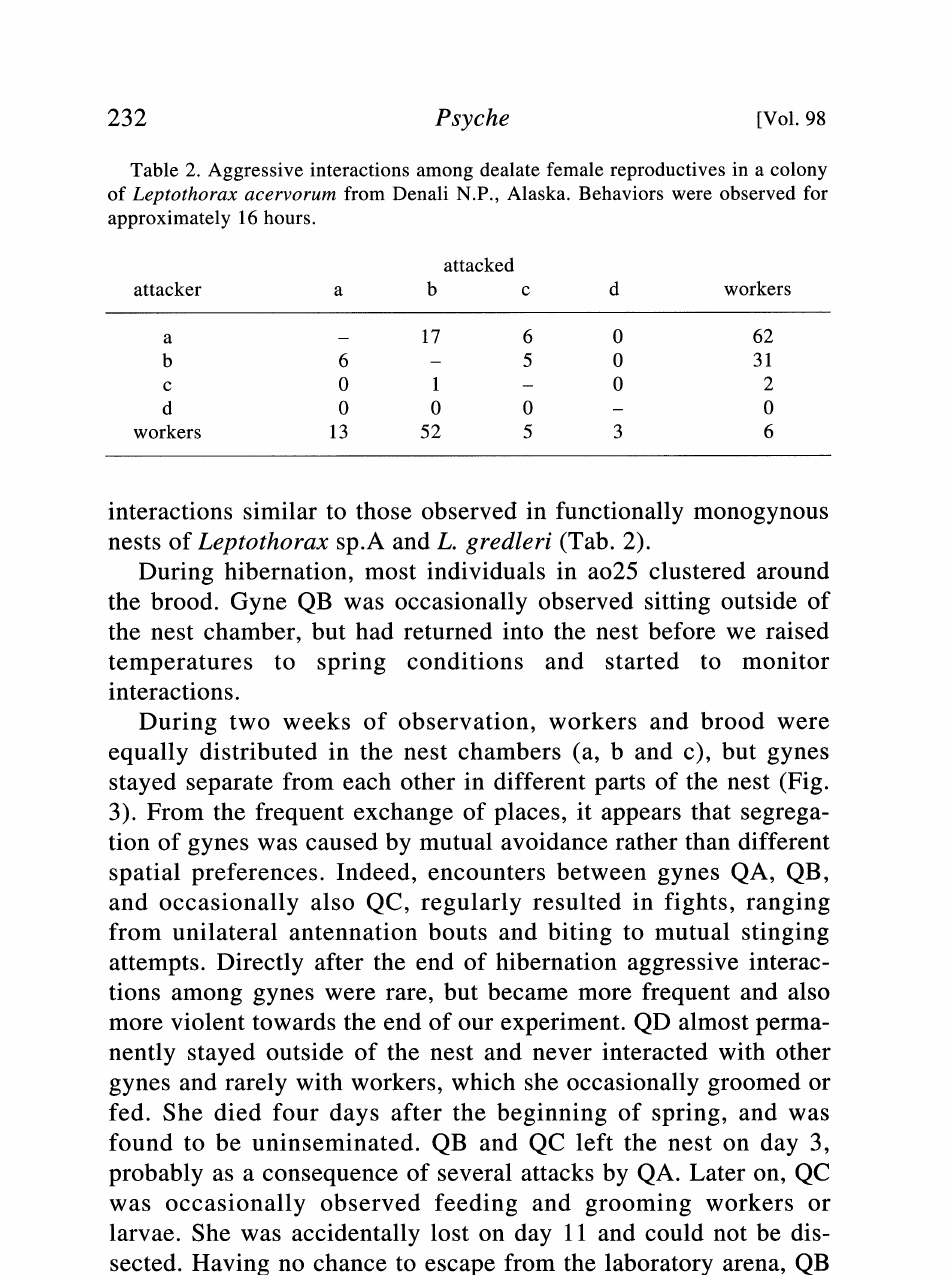
Table 2. Aggressive interactions among dealate female reproductives in a colony of Leptothorax acervorum from Denali N.P., Alaska. Behaviors were observed for approximately 16